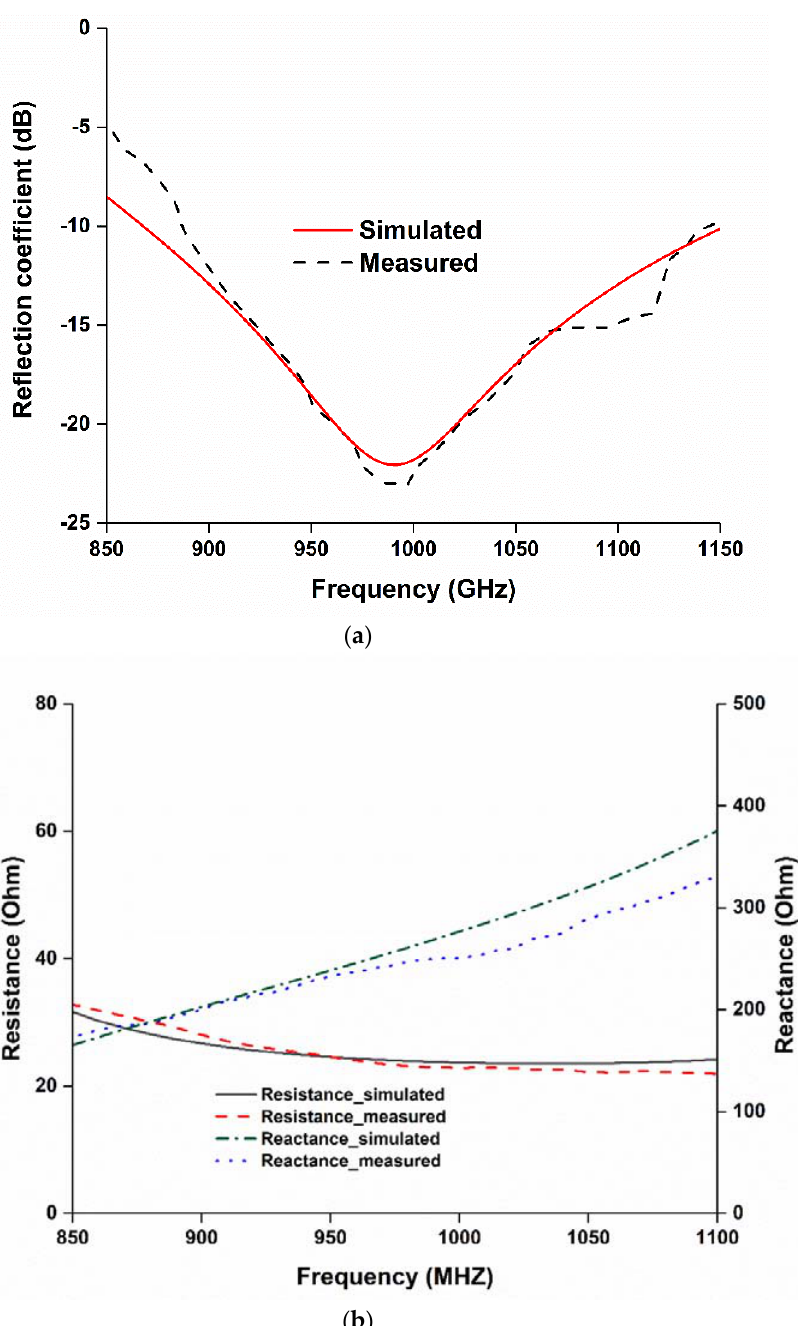
Figure 3. ( a ) Reflection coefficient and ( b ) input impedance of the proposed RFID tag.